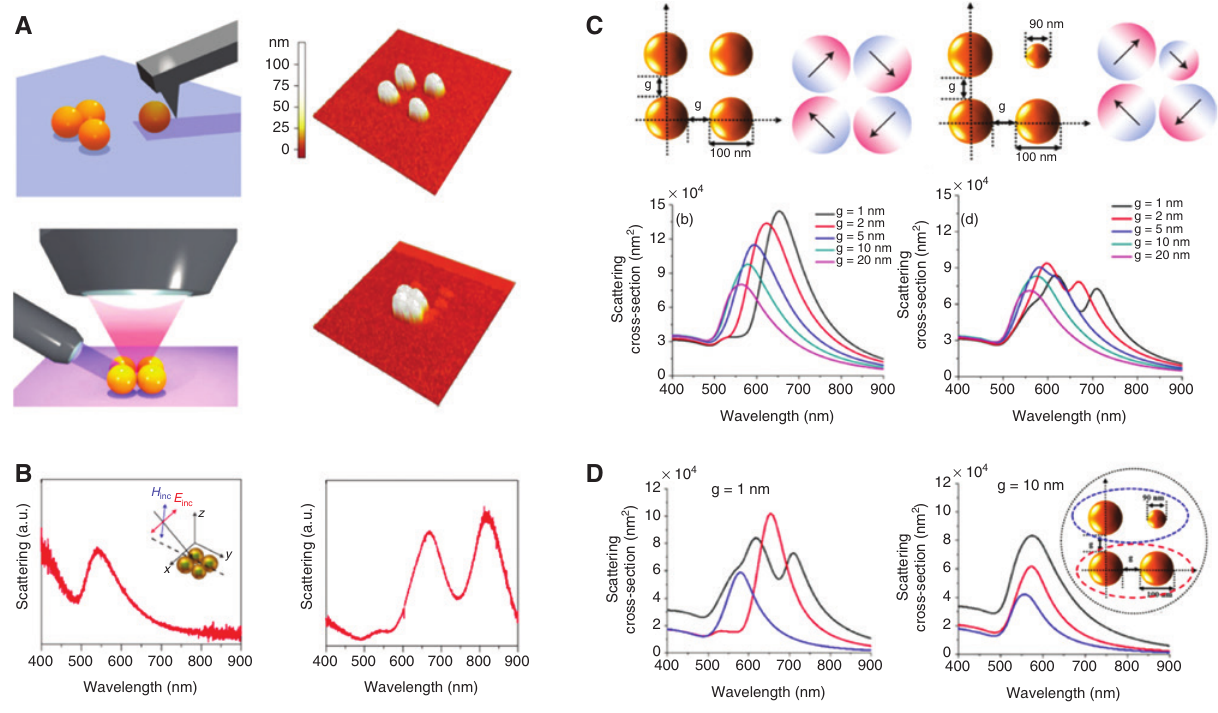
Figure 3: Plasmonic hybridization and Fano resonances. (A) Left, schematic of the AFM manipulation and optical scattering setup. Right, AFM images of the gold oligomers over an area of 1.25 μ m × 1.25 μ m. (B) Measured scattering spectra when the four nanoparticles are far apart (left) and when they are arranged in a